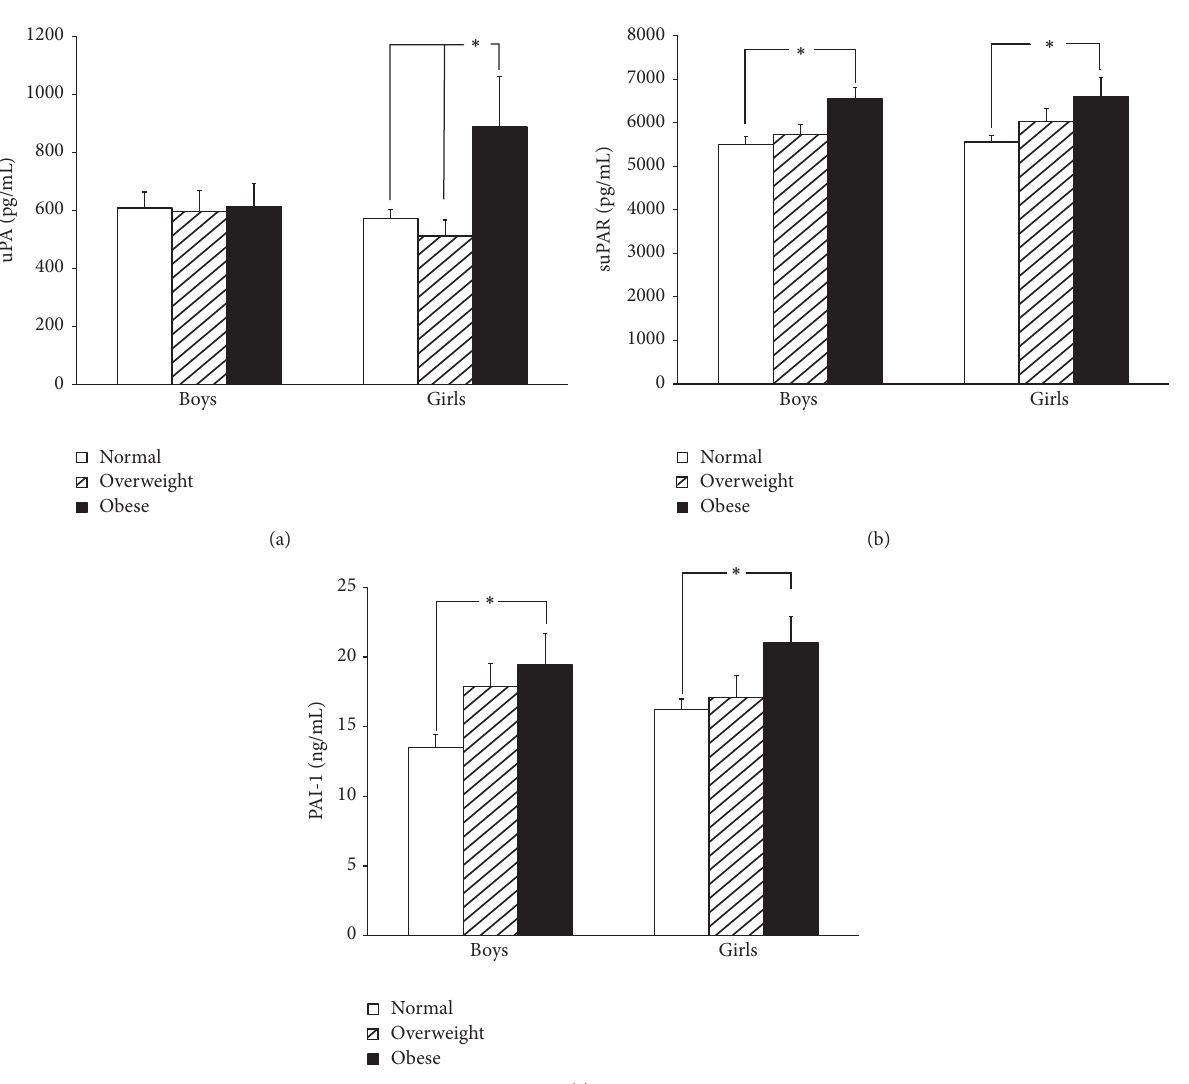
suPAR is associated with hsCRP in both boys and